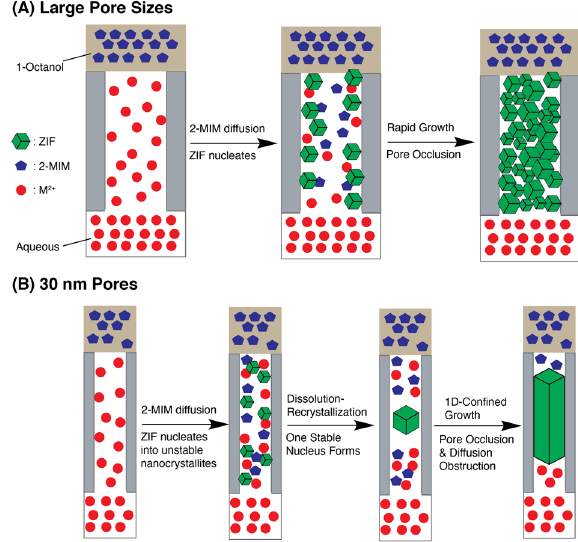
Fig. 6 Proposed ZIF growth mechanisms. Growth mechanisms inside the template pores of ( A ) larger than 30 nm, and ( B ) 30 nm in